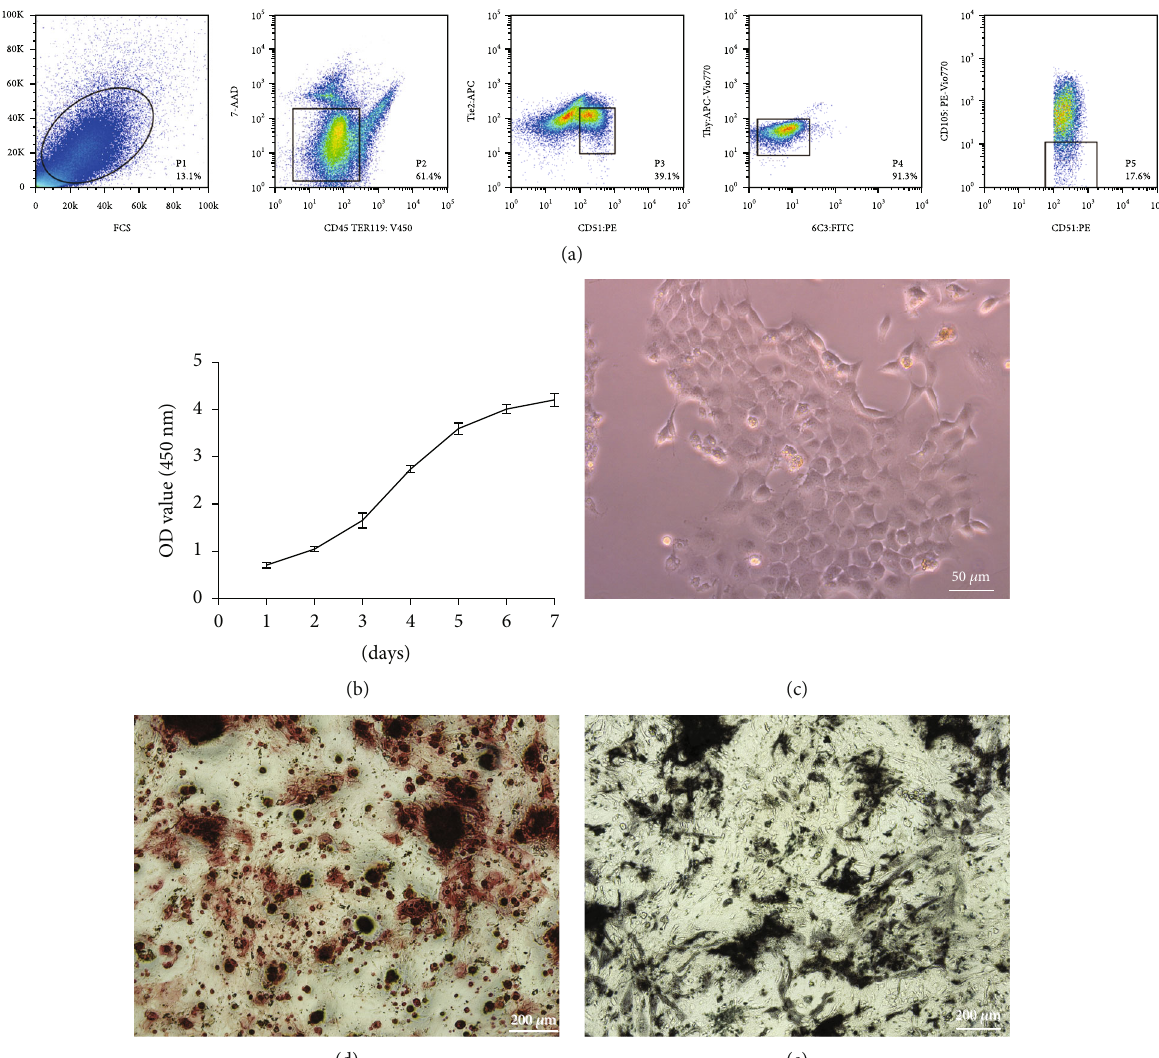
Figure 2: Isolation and identi fi cation of mSSCs. (a) Isolation of mSSCs. (b) Growth curve of mSSCs in vitro. (c) Colony formation of mSSCs. (d) Alizarin red S staining of mSSCs. (e) Alkaline phosphatase staining of